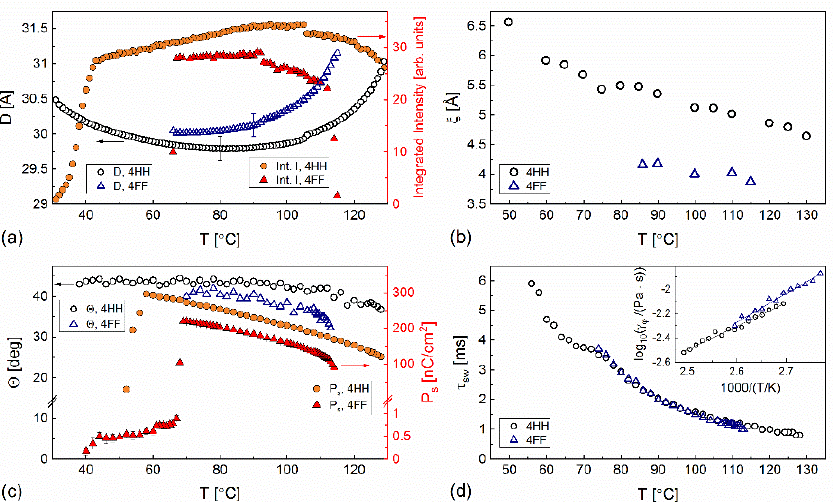
Figure 6. Physical properties of the smectic phases of 4HH (circles) and 4FF (triangles): temperature dependence of the smectic layer spacing 𝐷 and integrated intensity of the low-angle diffraction peak at 2θ ≈ 3.0° ( a ), correlation length 𝜉 within the smectic layers ( b ), tilt angle 𝛩 of molecules and spontaneous polarization 𝑃 𝑠 ( c ) as well as switching time 𝜏 𝑠𝑤 ( d ) and rotational viscosity 𝛾 𝜑 (inset in ( d )). All results were obtained on cooling. Left and right vertical axes in ( a ) and ( c ) apply to the data denoted with open and solid symbols, respectively.